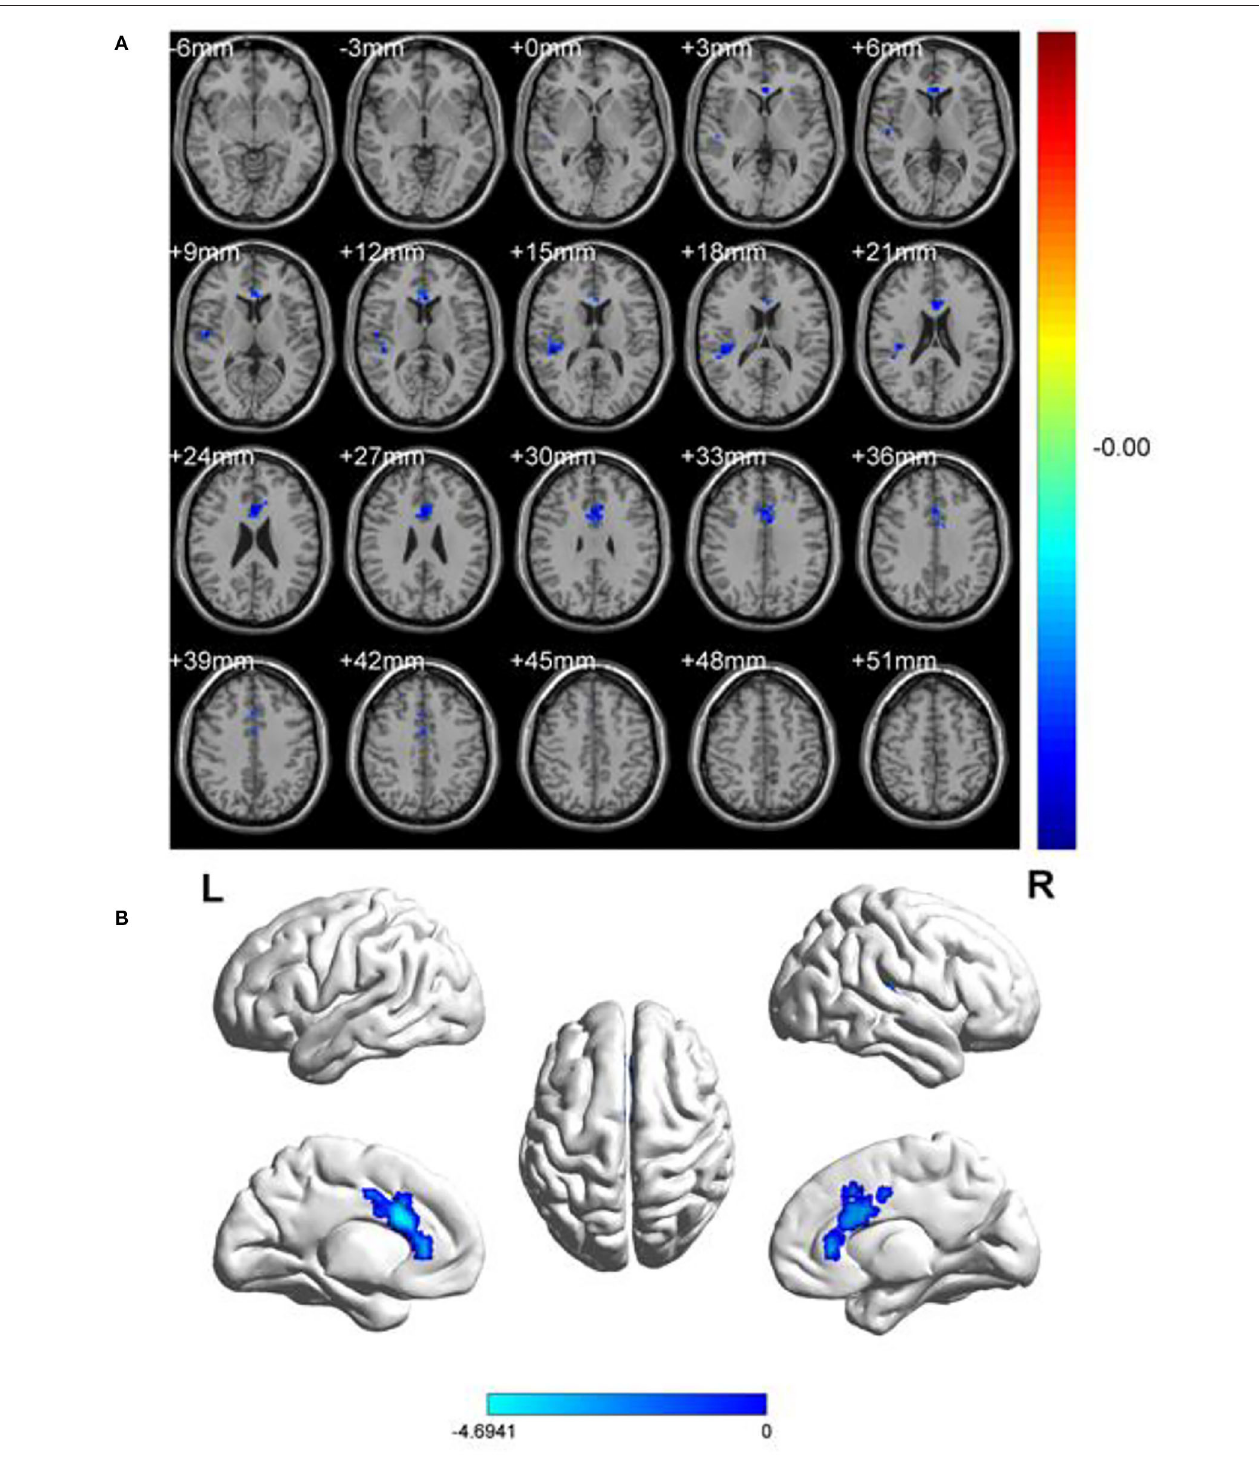
FIGURE 1 | Spontaneous brain activities of and healthy controls. (A) Different fALFF areas in patients with OF. (B) The blue areas represented lower fALFF values. L, left; R, right.